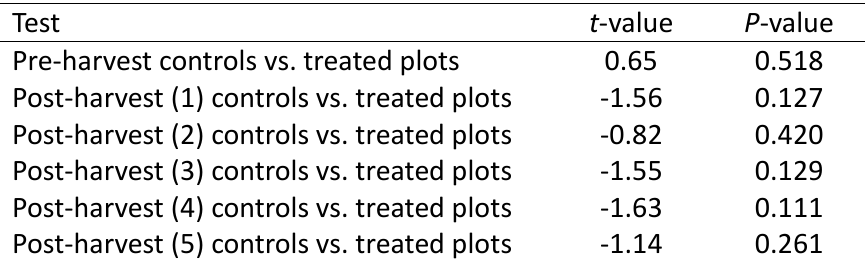
Table A1.8 . Year-specific treatment effects on density of American Redstart, according to multiple comparison analyses (DF =